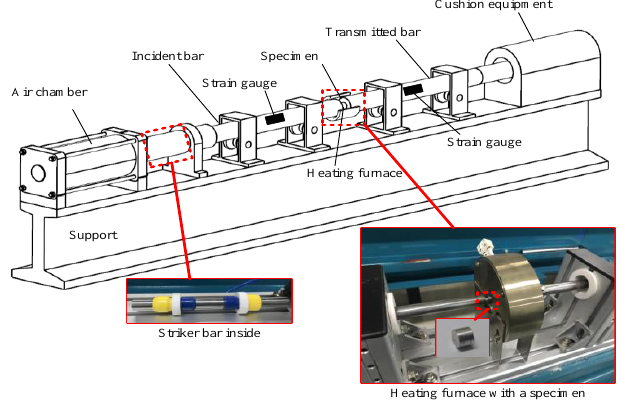
Figure 3. The diagram illustration of SHPB system.